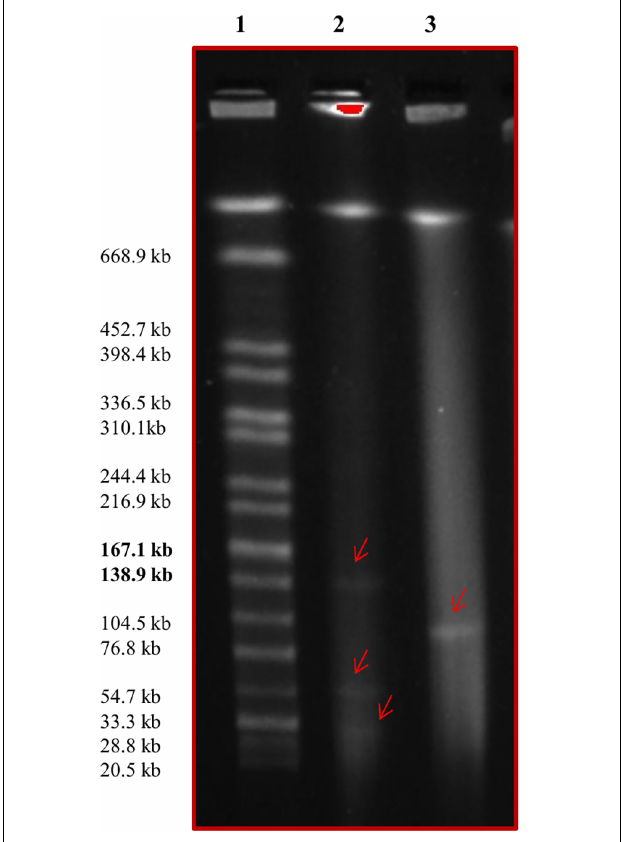
FIGURE 3 | Pulsed field gel electrophoresis image showing the presence of large plasmids. Lane 1 contains the Salmonella serovar Braenderup H9812 molecular marker. Lane 2 contains E. coli NCTC 50192 treated with S1 nuclease; the three large plasmids (147, 63, and 43.5 kb) are indicated with red arrows. Lane 3 contains Salmonella Ouakam strain GP016 treated with S1 nuclease; the red arrow indicates the presence of a ∼ 100 kb